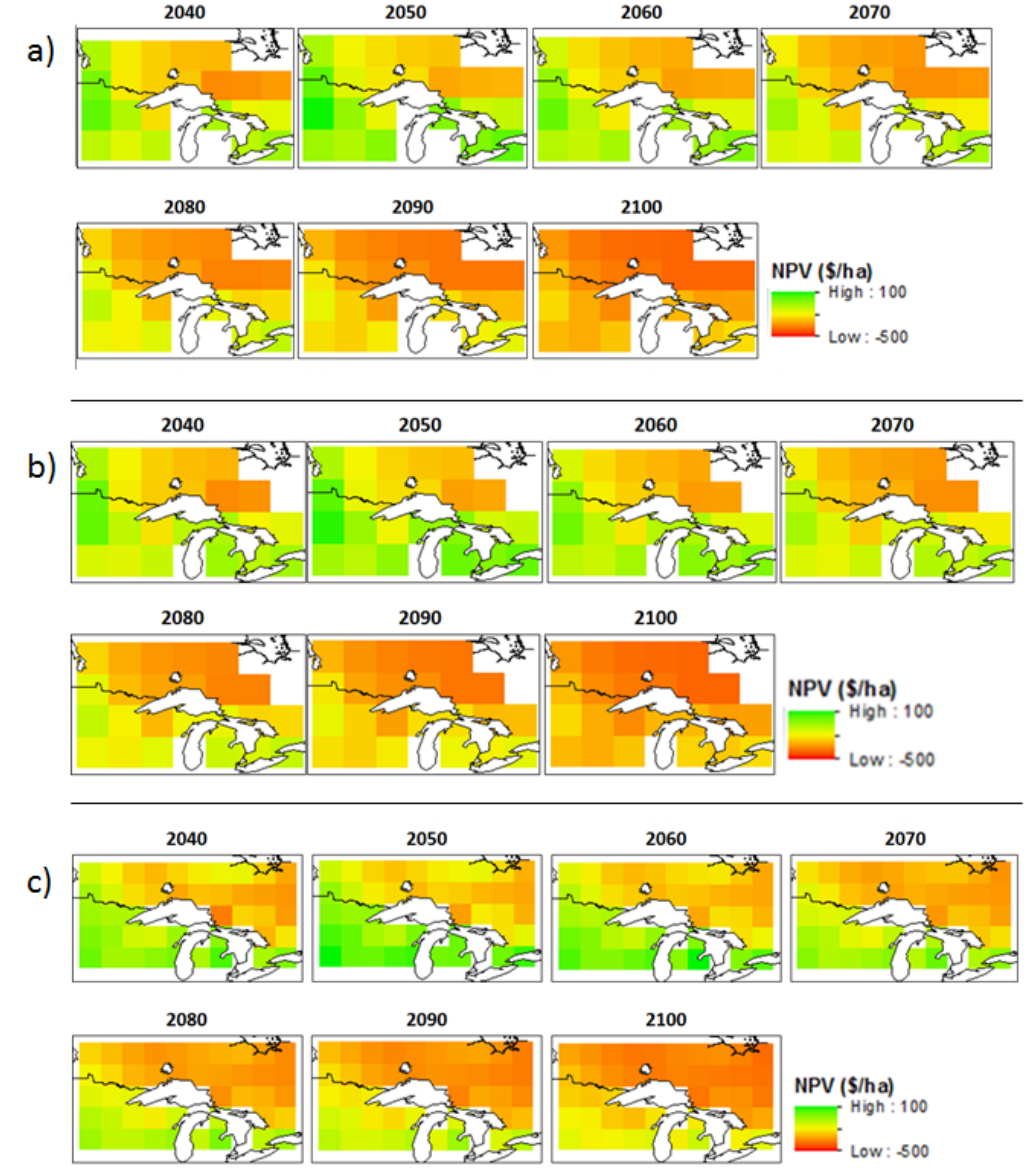
Figure 5. Spatial distribution of Net Present Values (NPVs) based on wood value only for the ( a ) CanESM2; ( b ) MIROC; and ( c ) MPI models.